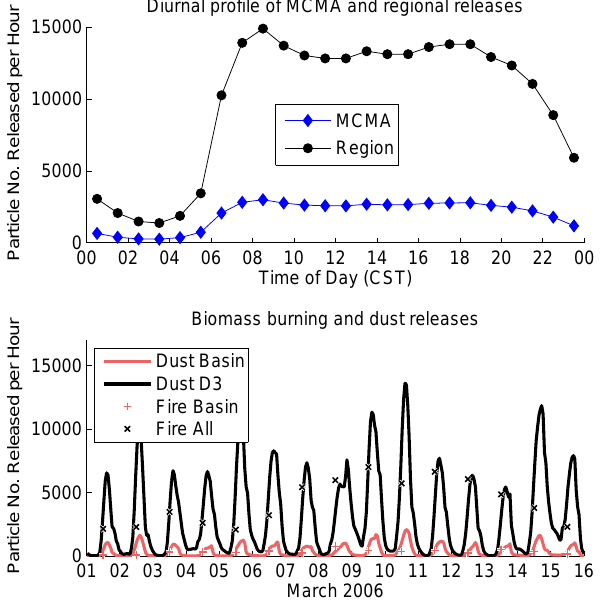
Fig. 2. Top: hourly profile of number of particles released for MCMA and regional emissions. Bottom: hourly emissions of dust and biomass burning smoke for 1–15 March 2006. For biomass, the value for each day is used from 8am until 8am the following day. D3 means WRF domain 3, see Fig.